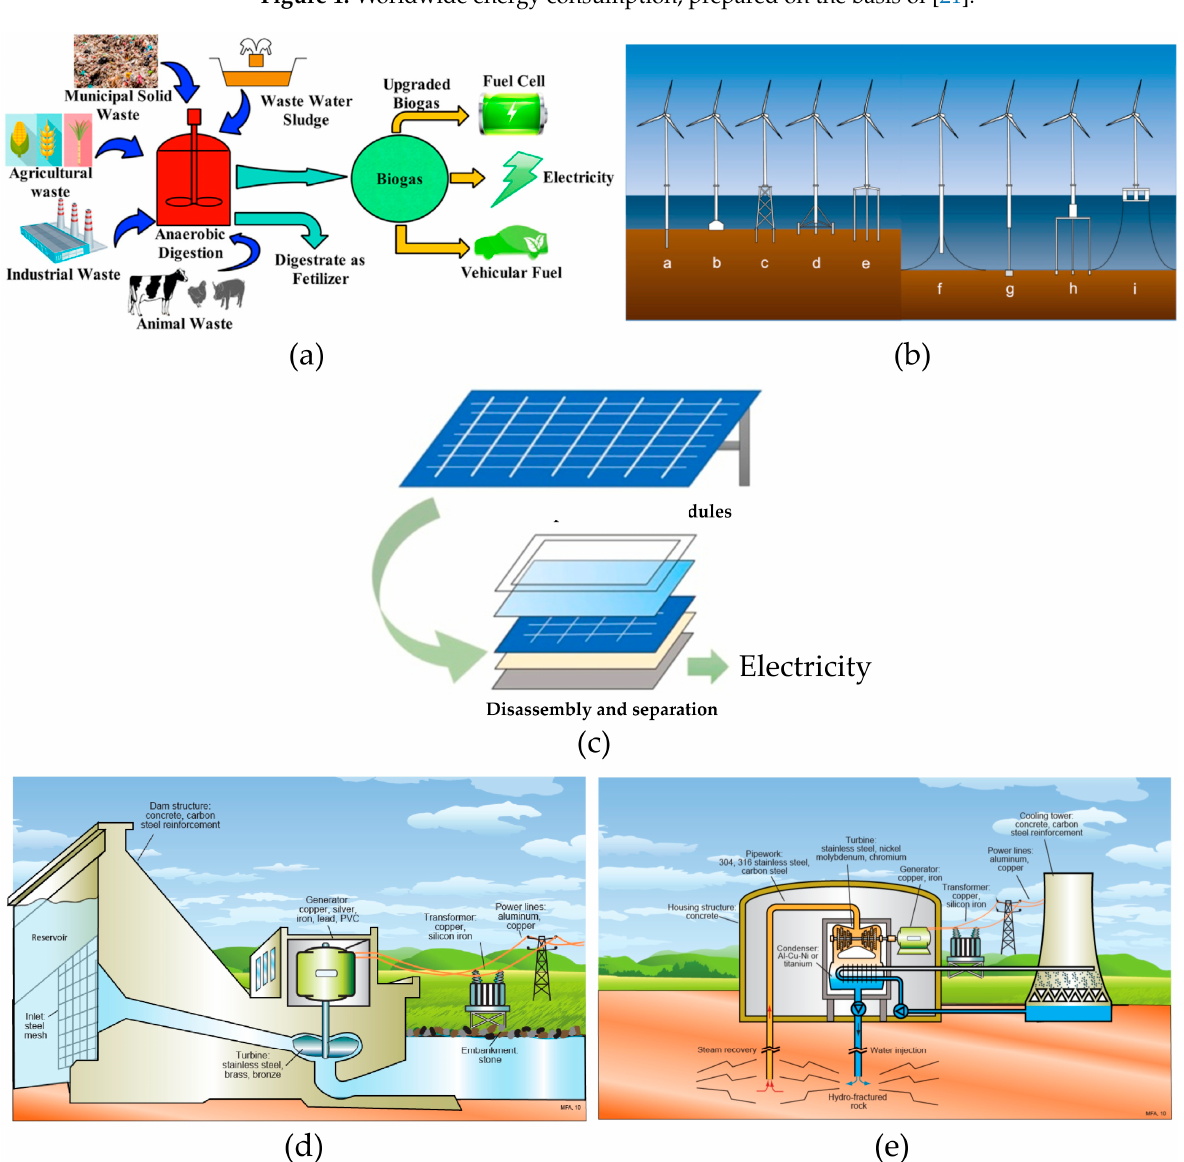
Figure 1. Worldwide energy consumption, prepared on the basis of [21].